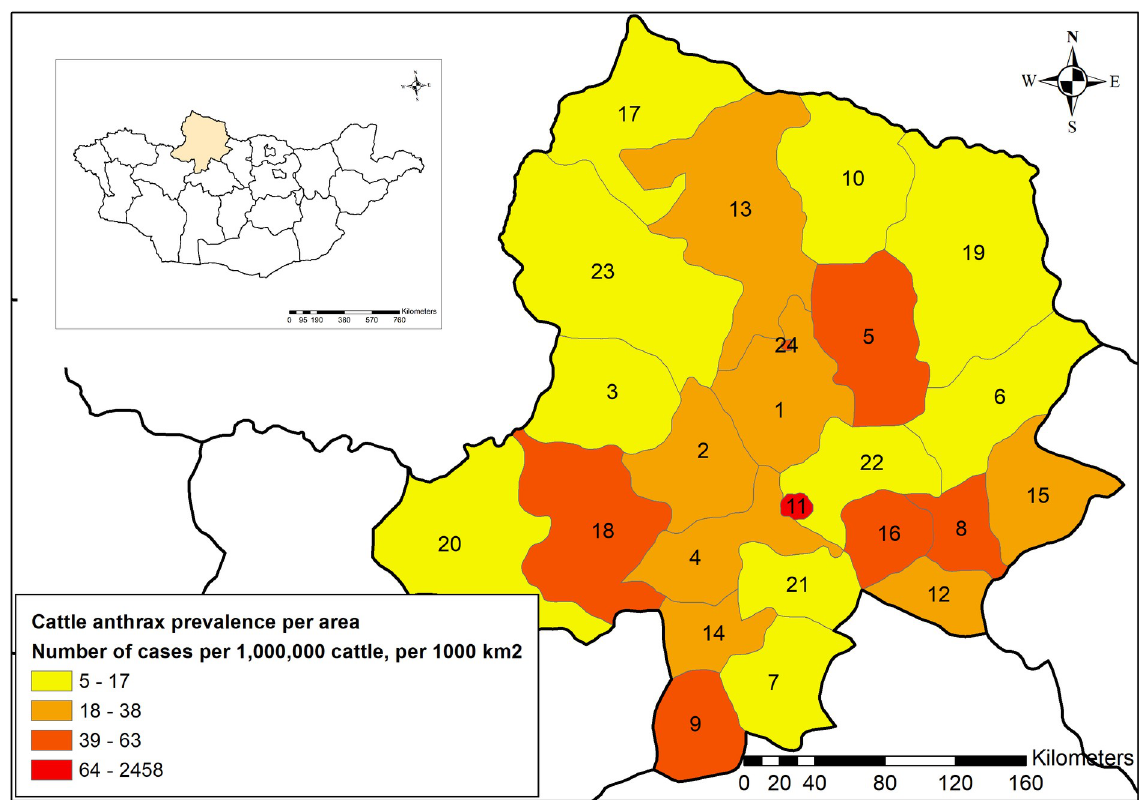
Fig 2. Annual cattle anthrax prevalence per 1,000,000 population per 1000 km 2 in Khuvsgul Province by districts. Numbers correspond to the ID number in Table 2. The Murun (district ID 11), the central administrative district of Khuvsgul Province, had the highest cattle anthrax prevalence per area. The maps are reprinted from [28] under a CC BY license, with permission from DIVA-GIS and Dr. Robert Hijmans; see S1